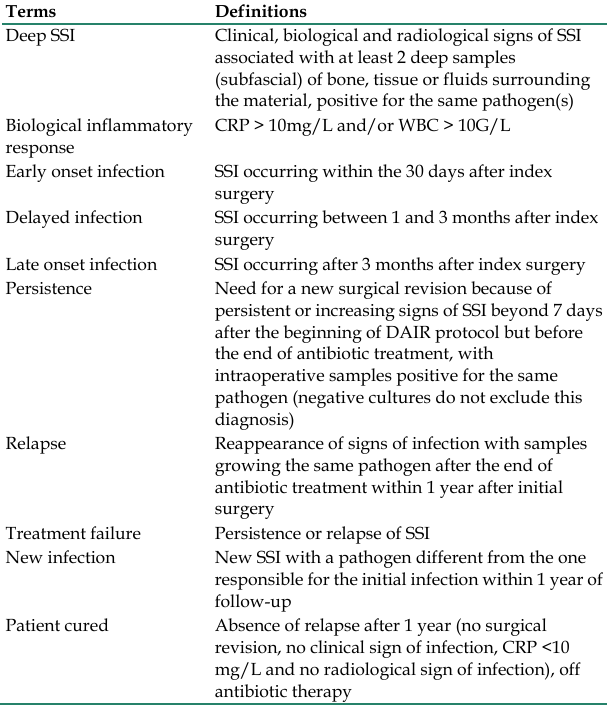
Table 1. Definition of terms used in this study Terms Definitions Deep SSI